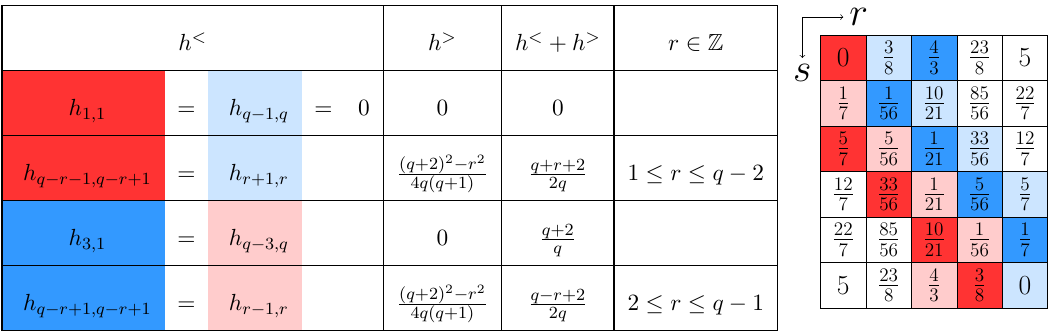
(cid:0) 3 (cid:1) ; 2 for ^ c = 4( q + 3) =q , q (cid:21) 3. (The third line 2